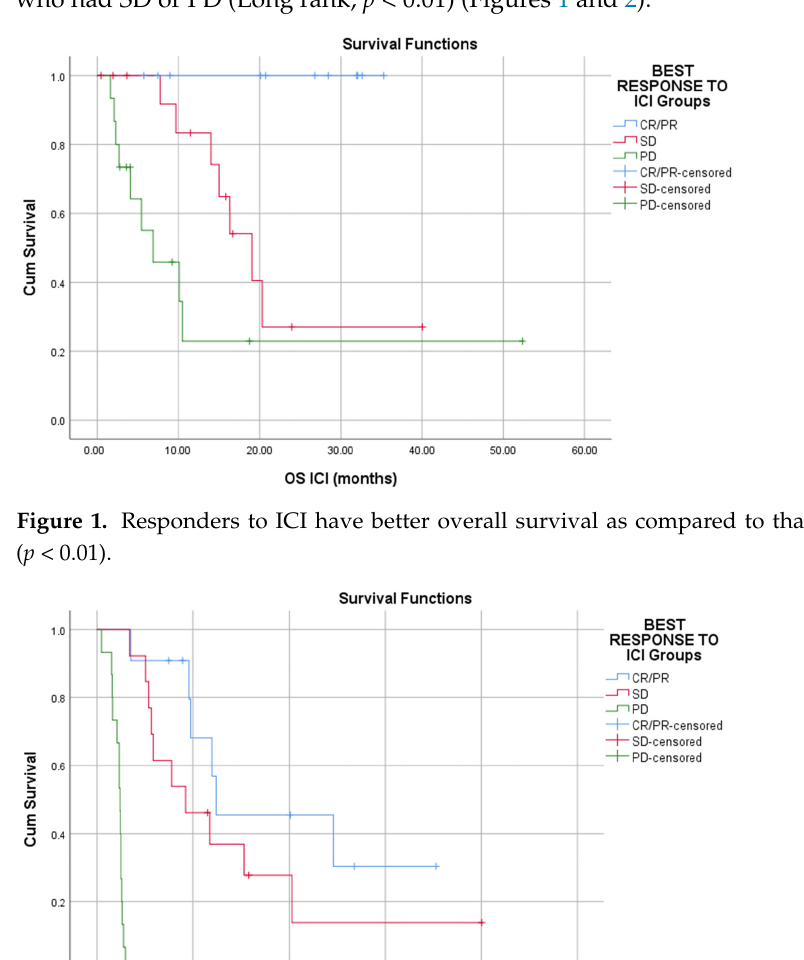
Figure 3. Presence of more than three metastatic sites is associated with worse PFS ( p = 0.023). No other demographics or disease features correlated with survival. Multivariate Cox proportional hazard models did not reveal any independent prognostic factors for PFS or OS (Table 2).